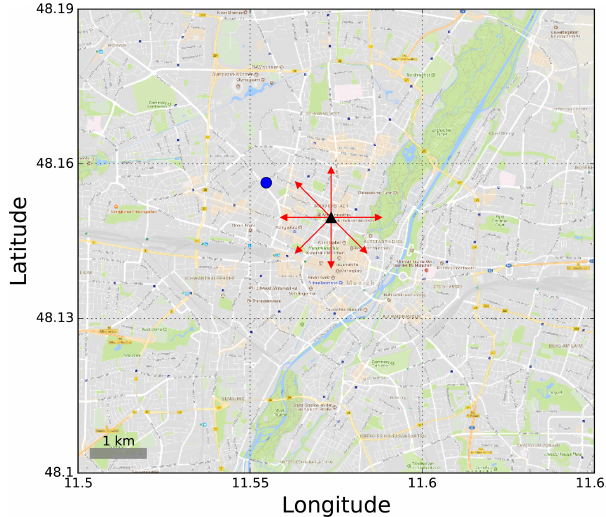
Figure 1. Locations of the MAX-DOAS measurement site (black triangle) and the ambient-air-quality monitoring station (blue dot). The red arrows indicate the azimuth viewing directions, φ , of the MAX-DOAS observations. The base map is taken from © Google Maps (https://www.google.com/maps/ (last access: 1 Au- gust